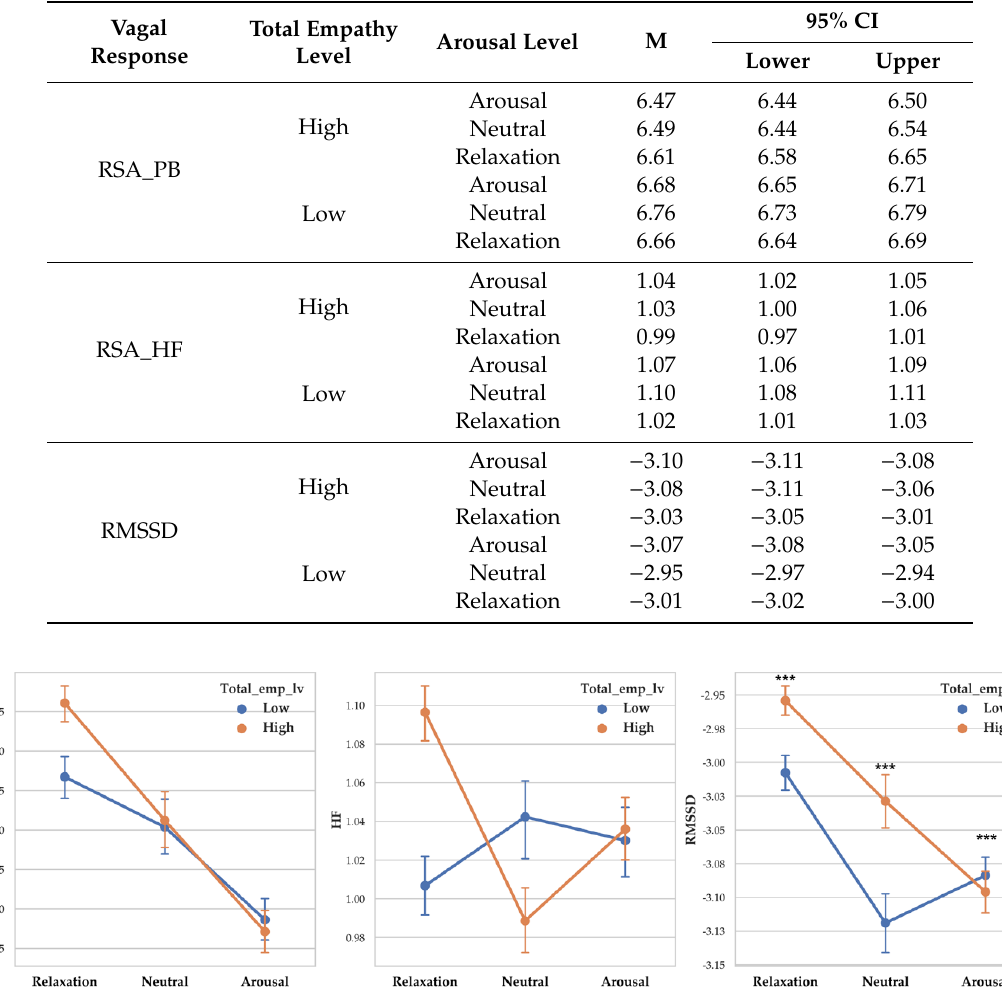
Figure 11. Point graph of vagal response depending on identification empathy level when participant empathized with arousal levels. Total_emp_lv refers to total empathy level. Point means mean of vagal responses. Asterisk means significant vagal responses difference according to cognitive empathy level. (***: p < 0.001).